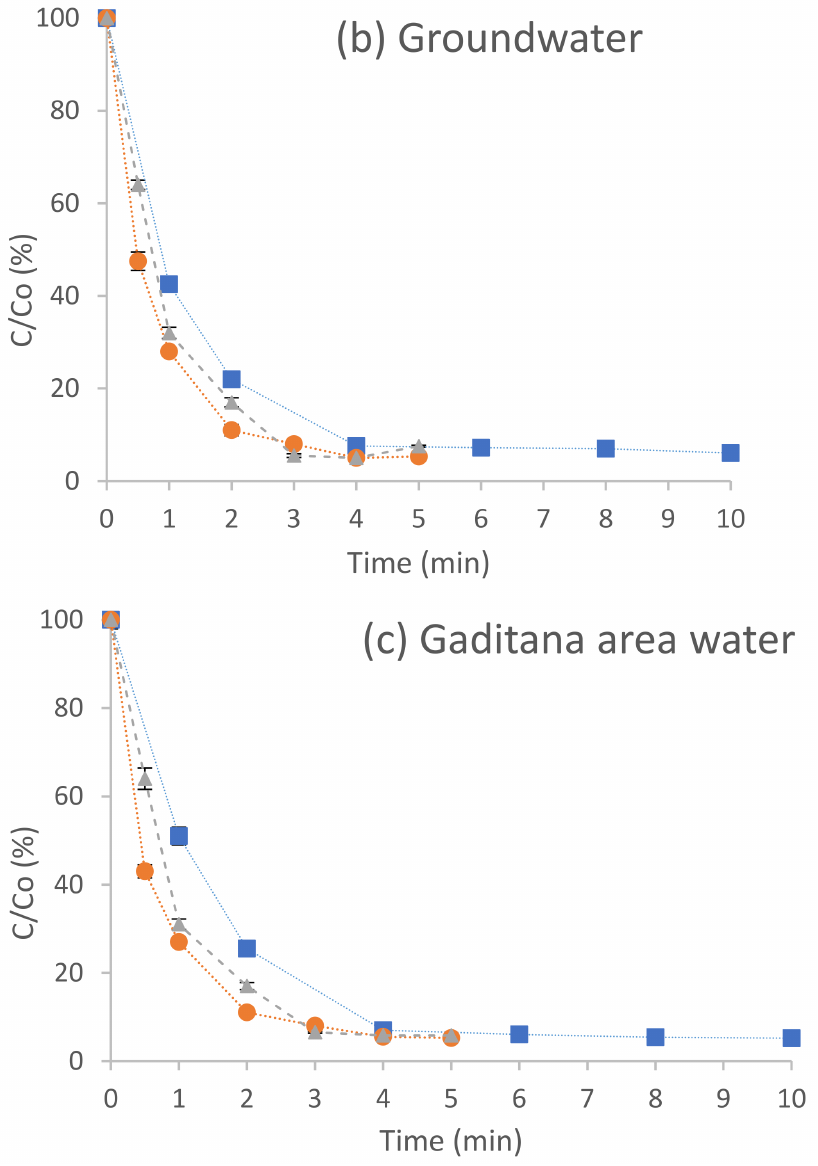
Figure 2. Degradation of the pesticide terbuthylazine in ultrapure water ( a ), groundwater ( b ) and water from the Gaditana area ( c ) by ultraviolet radiation ( (cid:4) ), hydrogen peroxide photolysis ( • ) and photo-Fenton ( (cid:78) ) in a batch reactor. Table 5. Degradation kinetics of terbuthylazine after ultraviolet (UV) radiation, hydrogen